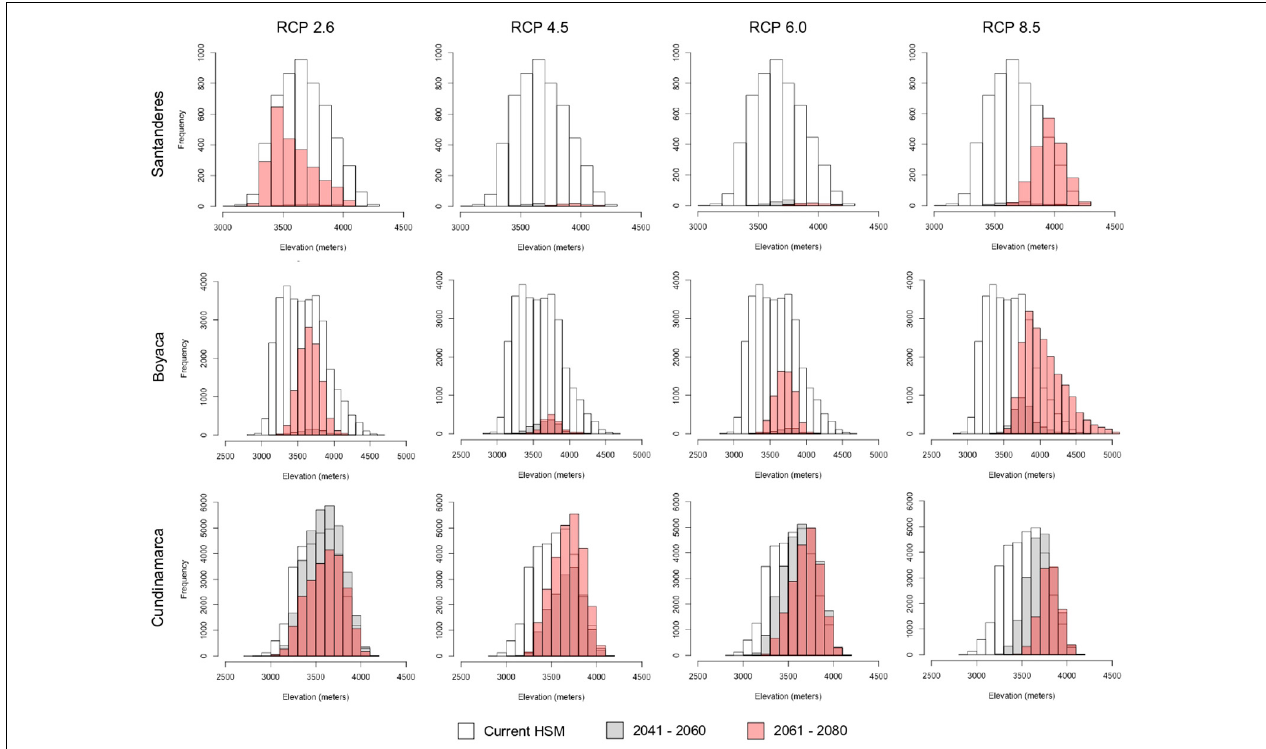
TABLE 2 | Change of suitable area for the projections of the ensemble Habitat Suitability Model of Polylepis quadrijuga to four climatic change scenarios (RCP) and two time periods. Scenario Stable Loss Gain Stable Loss Gain RCP